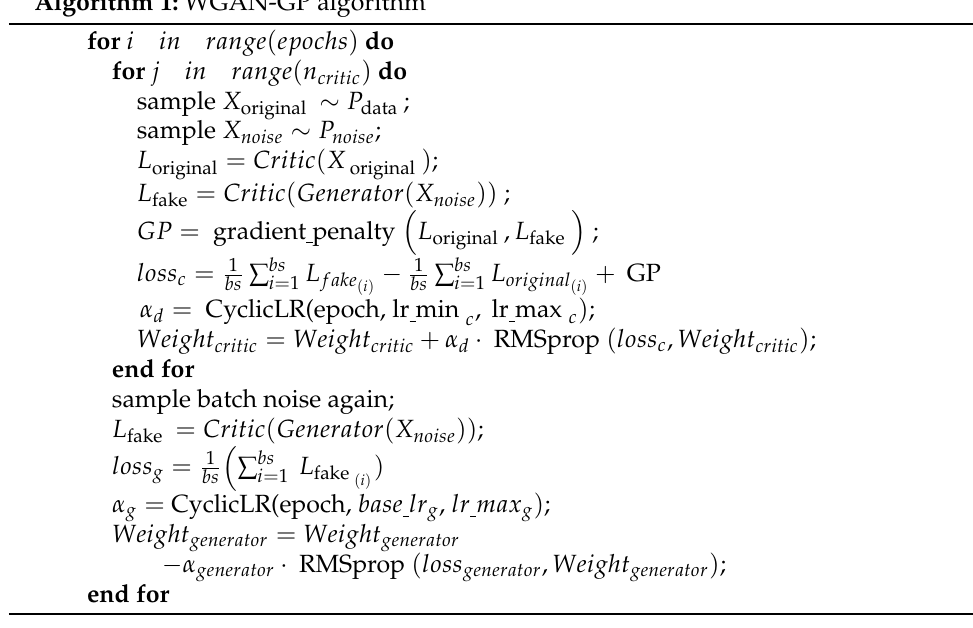
Algorithm 1: WGAN-GP algorithm